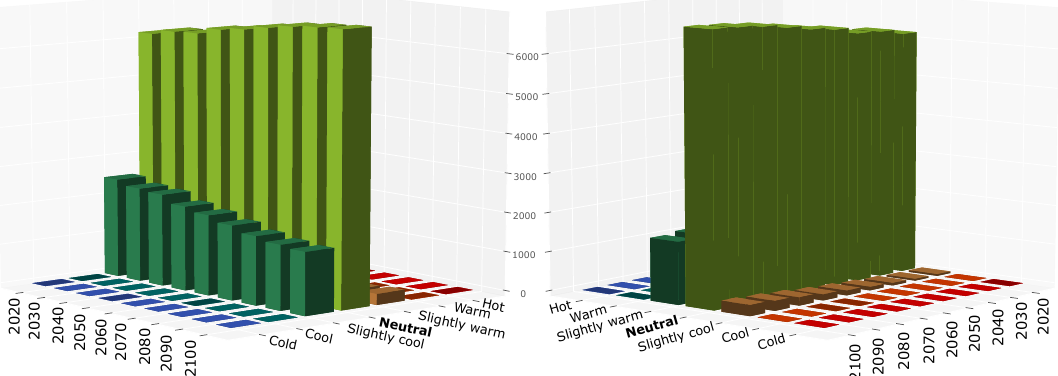
Figure 8. Comfort results taking into account the CTE-2013 standard and the Pamplona weather file generated with Meteonorm based on the IPCC scenario (A2).